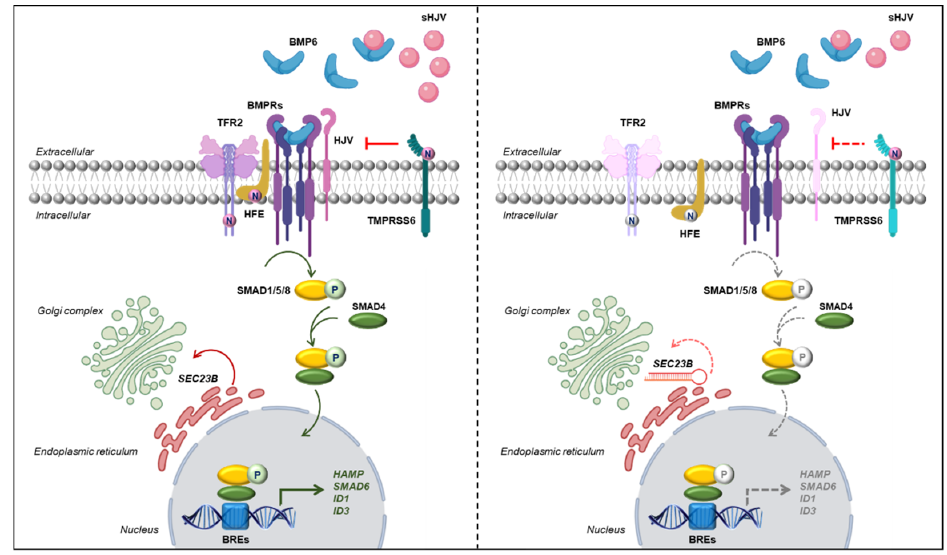
Figure 6. Schematic models of the mechanism of iron overload in SEC23B loss-of-function hepatic cells . Left panel . At physiological conditions, SEC23B mediates the anterograde trafficking of correctly folded proteins and post-translational modification. Correctly processed proteins (TFR2, HJV, HFE) associated in the membrane complex that mediates activation of BMP/SMADs pathway. The activation of the complex results in the phosphorylation of SMAD1/5/8 that in turn mediates the activation of the transcription of the BMP target genes, HAMP , SMAD6 , ID1 , and ID3 . Right panel . SEC23B loss-of-function determines the decreased glycosylation of membrane proteins TFR2, HFE, and HJV (light colored), which accounts for the reduced expression and stabilization of the membrane complex. Therefore, BMP6 failed to activate the pathway, and this finally causes the suppression of HAMP gene transcription.